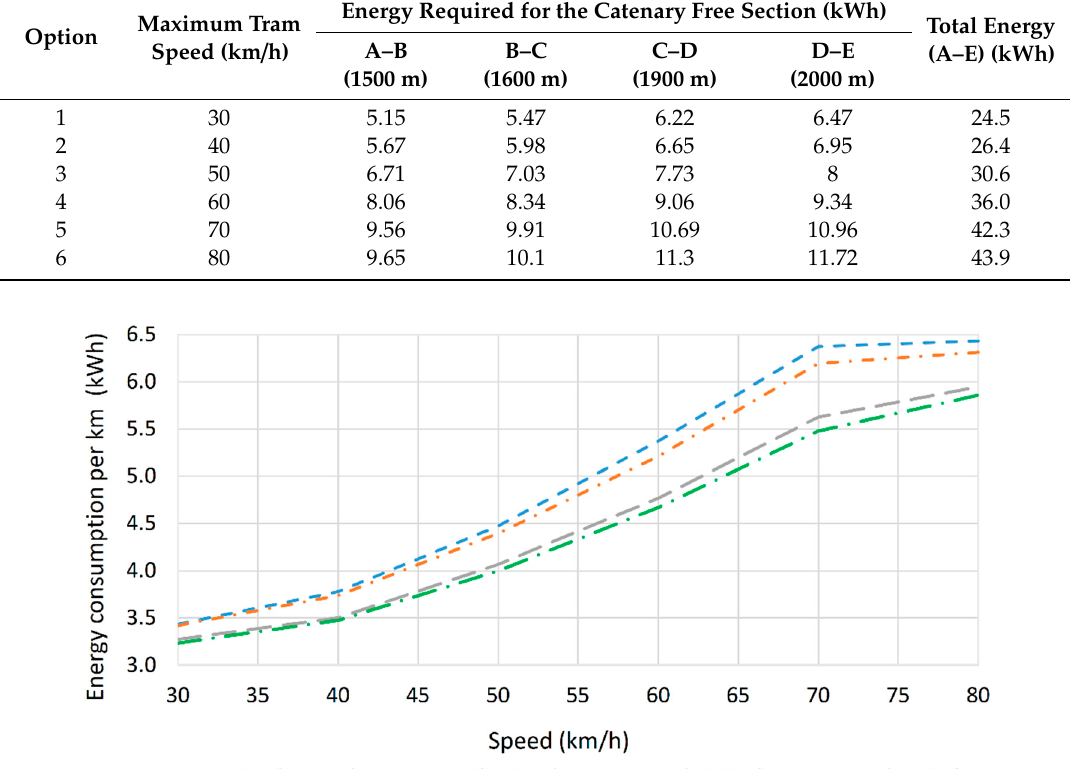
Table 4. Simulation results for the catenary free section.